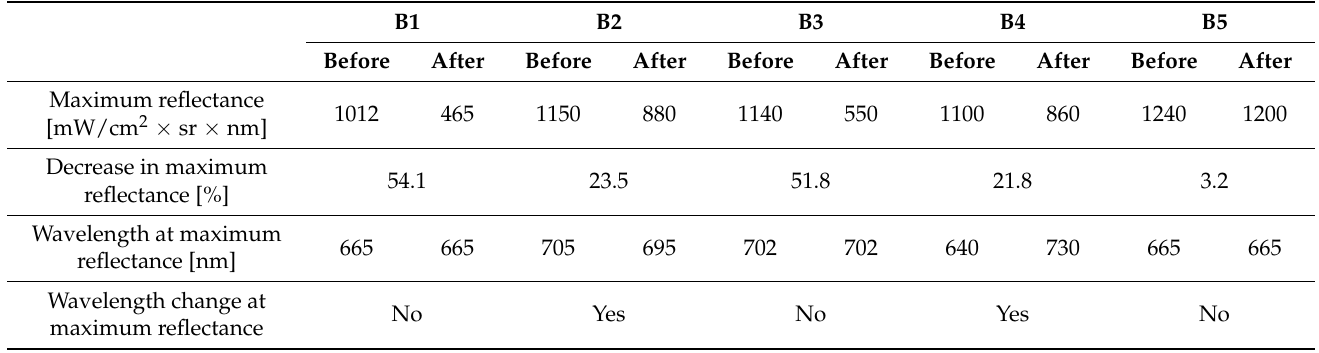
Figure 6. The correlation between the reflectance and the wavelength for the B1 dye before and after the Q-Switched Nd:YAG laser application. Table 2. Characteristics of the B1-B5 dye reflectance curves before and after the laser